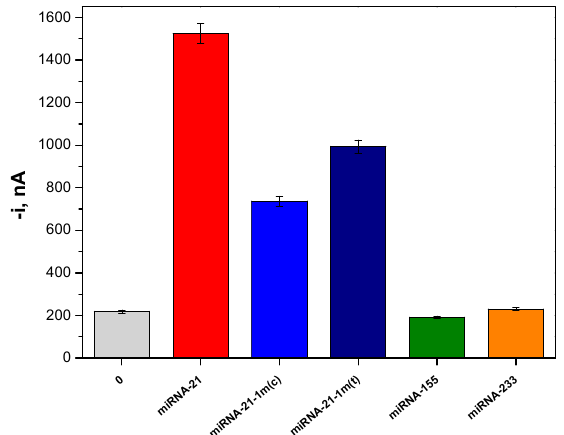
Figure 5. Selectivity of the developed electrochemical biosensor for determination of miRNA-21. Amperometric responses measured in the absence or in the presence of 25 pM miRNA-21, central (1-m(c)), terminal (1-m(t)), and non-complementary (NC) sequences (miRNA-155 and miRNA-223). Error bars estimated at triple the standard deviation of three replicates.